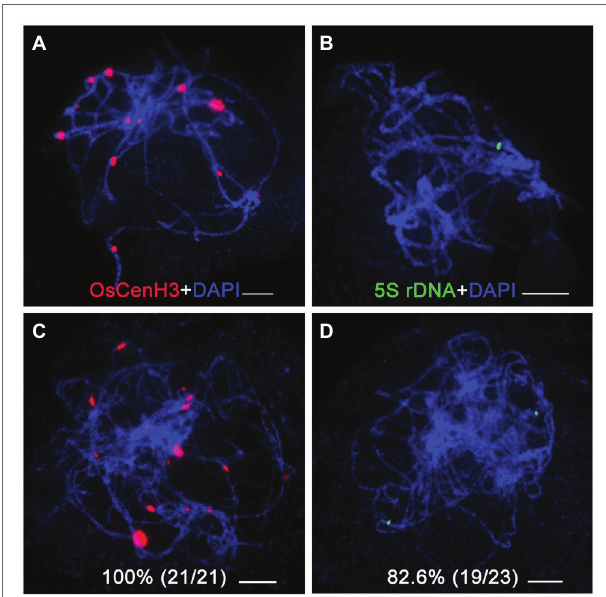
FIGURE 5 | Homologous chromosomes paring is impaired in osbrca2-1 mutant. Homologous pairing analysis by fluorescent in situ hybridization (FISH) using OsCenH3 (red) and 5 S rDNA (green) probes in wild-type (A,B) and osbrca2-1 mutant (C,D) . Chromosomes (blue) are stained with DAPI. Percentage represents the number of abnormal cells, n = 21 and 23, respectively. Bars = 5 μ